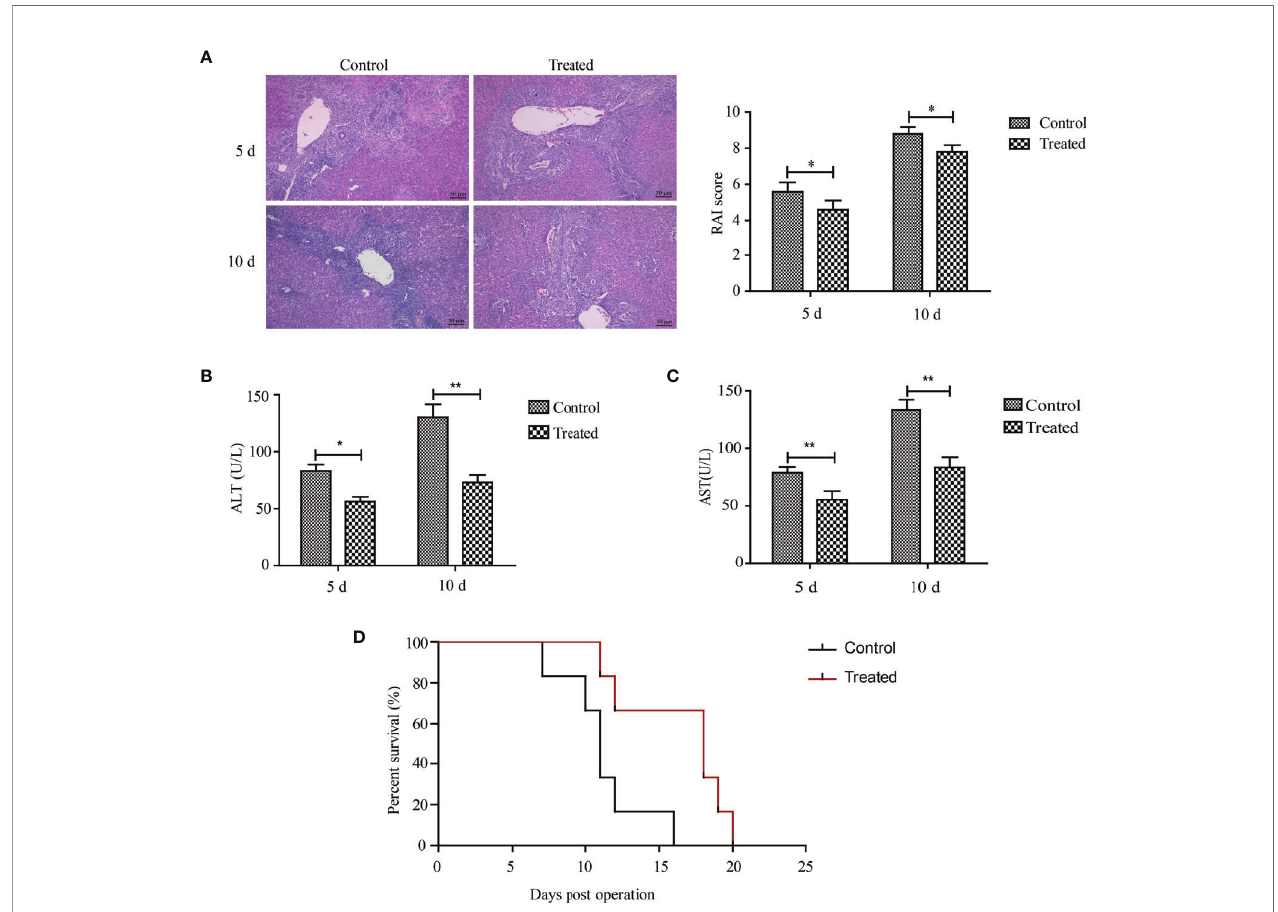
FIGURE 6 | Therapeutic effects of glycyrrhizic acid on liver transplantation. After the donor ’ s blood was heparinized, livers of the glycyrrhizic acid and control groups were perfused with organ protection solution with or without 200 mg/ml glycyrrhizic acid. (A) Representative H&E sections and RAI scores of grafted livers (magni fi cation, ×200). Milder parenchymal necrosis, less in fl ammatory cell in fi ltration, and reduced destruction of bile ducts were observed in the glycyrrhizic acid- treated group compared with the control group. (B, C) Serum levels of ALT and AST between glycyrrhizic acid-treated group (n=6) and control group. Data are expressed as the mean ± SEM from three independent experiments. * p < 0.05; ** p < 0.01. (D) Survival curve of recipient rats after liver transplantation. Overall survival was longer in the glycyrrhizic acid group than in the control group. (n=6, median (days): control group vs. treated group = 11 vs. 18, c 2 = 6.065, p =